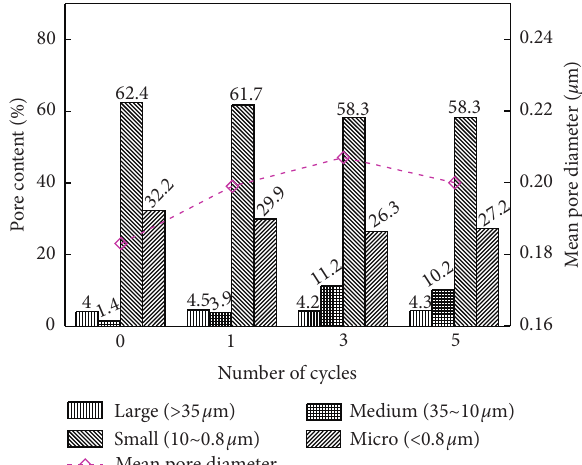
Figure 6: Variation in pore content and mean pore diameter of compacted loess specimens subjected to wetting-drying-freezing-thawing